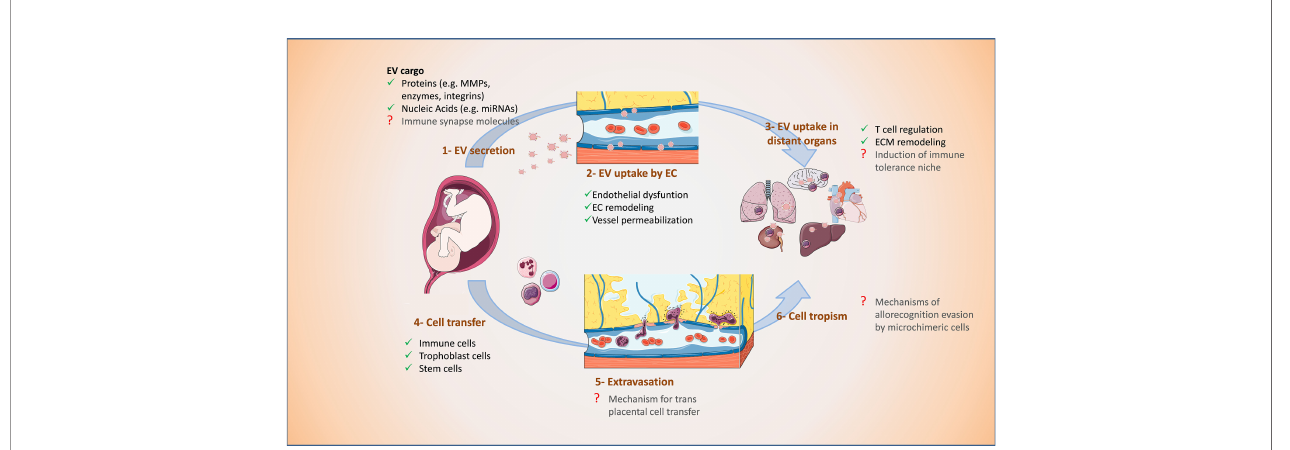
FIGURE 3 | Proposed supportive effect of fetal EVs on microchimerism during pregnancy. 1. Fetal EVs are secreted mainly by the placenta and reach the maternal circulation. 2. Fetal EVs are taken up by endothelial cells (EC), alter their morphology and function, and cause vessel permeabilization. 3. EVs can also reach distant organs, in fl uence their immune cell environment and induce changes in their extracellular matrix (ECM). 4. Fetal cells can trespass the placental barrier and access maternal vessels. 5. Pro fi ting from the EC alterations, fetal cells can extravasate maternal vessels and 6. Access the parenchyma of distant organs as microchimeric cells. Processes indicated with a red question mark are yet to be con fi rmed. The fi gure was drawn using pictures from 105